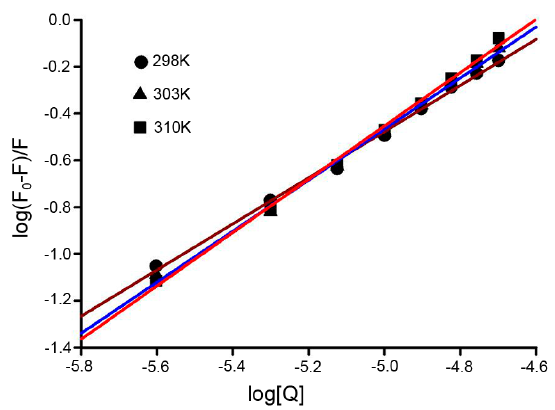
Figure 5. Plots of log[( F 0 − F )/ F ] versus log[ Q ] used to assess the quenching effect of Dp44mT on HSA